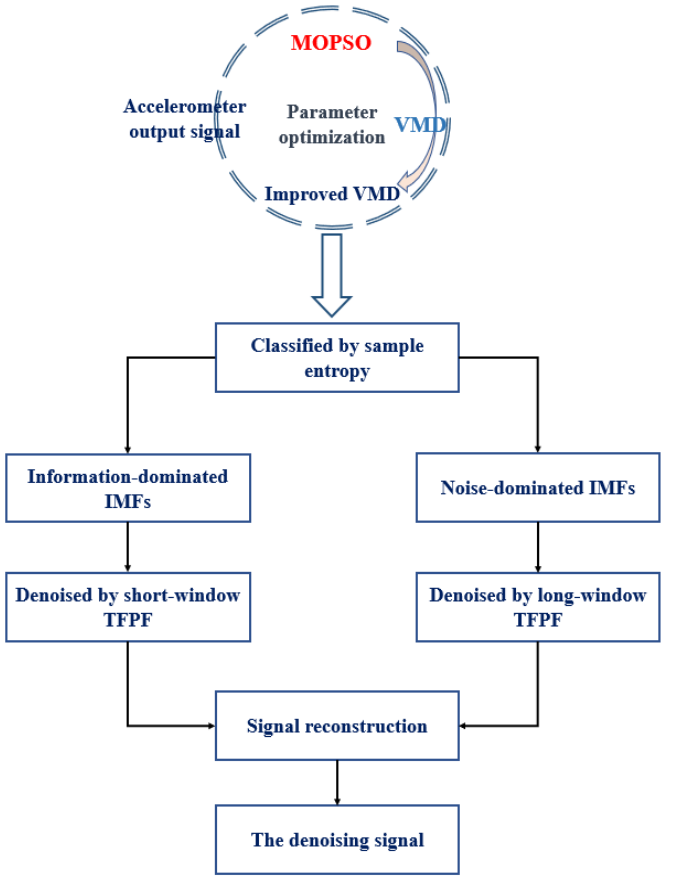
Figure 2. The flow diagram of the improved VMD and TFPF hybrid denoising algorithm.